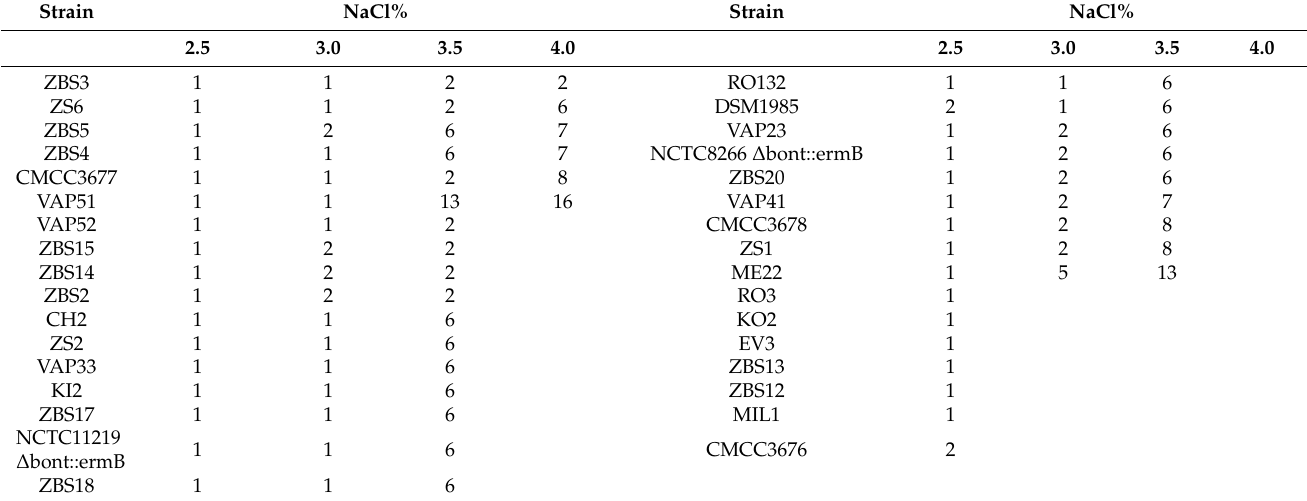
Table 5. Growth of nontoxic isolates, NCTC8266 ∆ bont::ermB and NCTC11219 ∆ bont::ermB at 30 ◦ C in RCM broth with 2.5%–4.5% NaCl. Growth was monitored for 21 days for three replicates per strain. None of the strains grew at 4.5% NaCl.